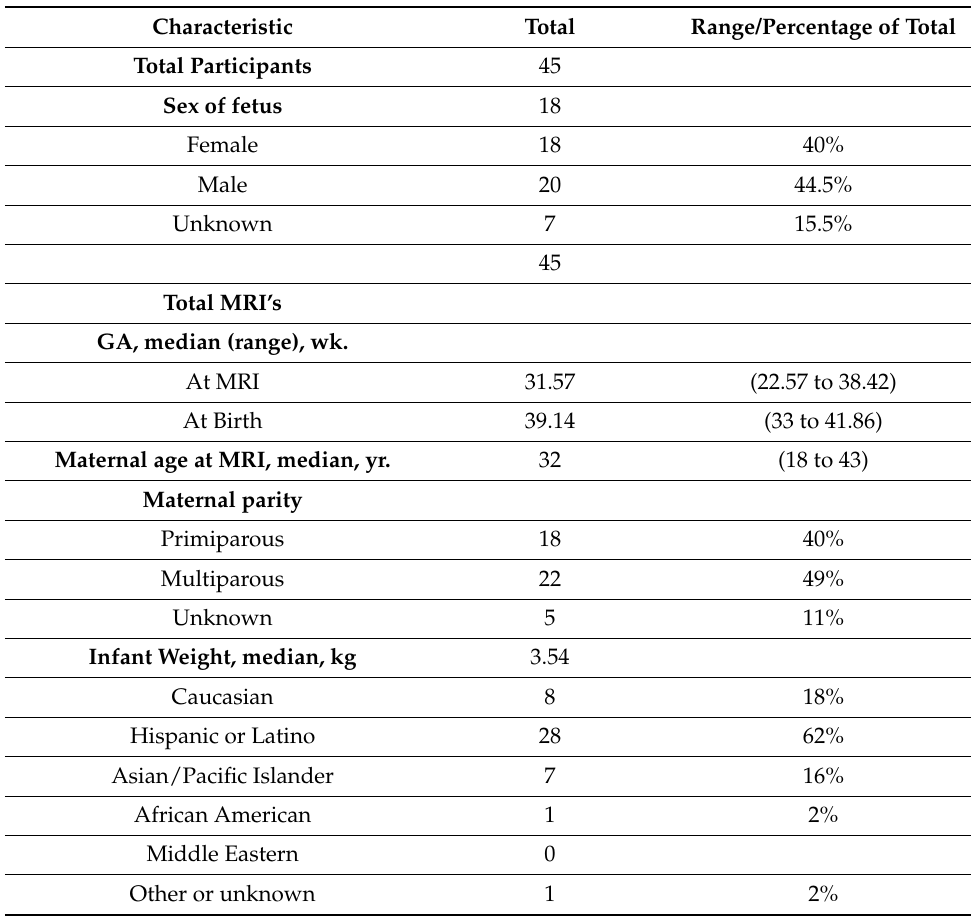
Table 1. Study participants’ demographic